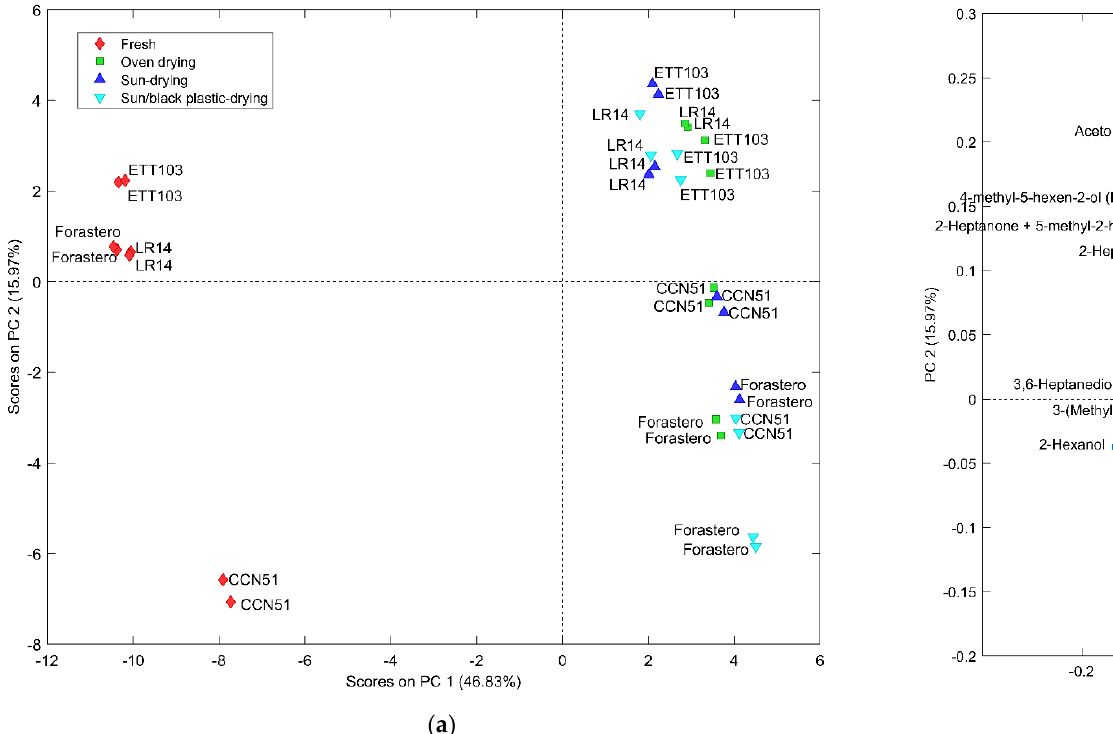
Figure 3. Scores ( a ) and loadings ( b ) of principal component analysis (PCA) constructed with volatiles from fresh and dried bulk (Forastero and CCN-51) and fine-flavor (ETT-103 and LR-14) cocoa.